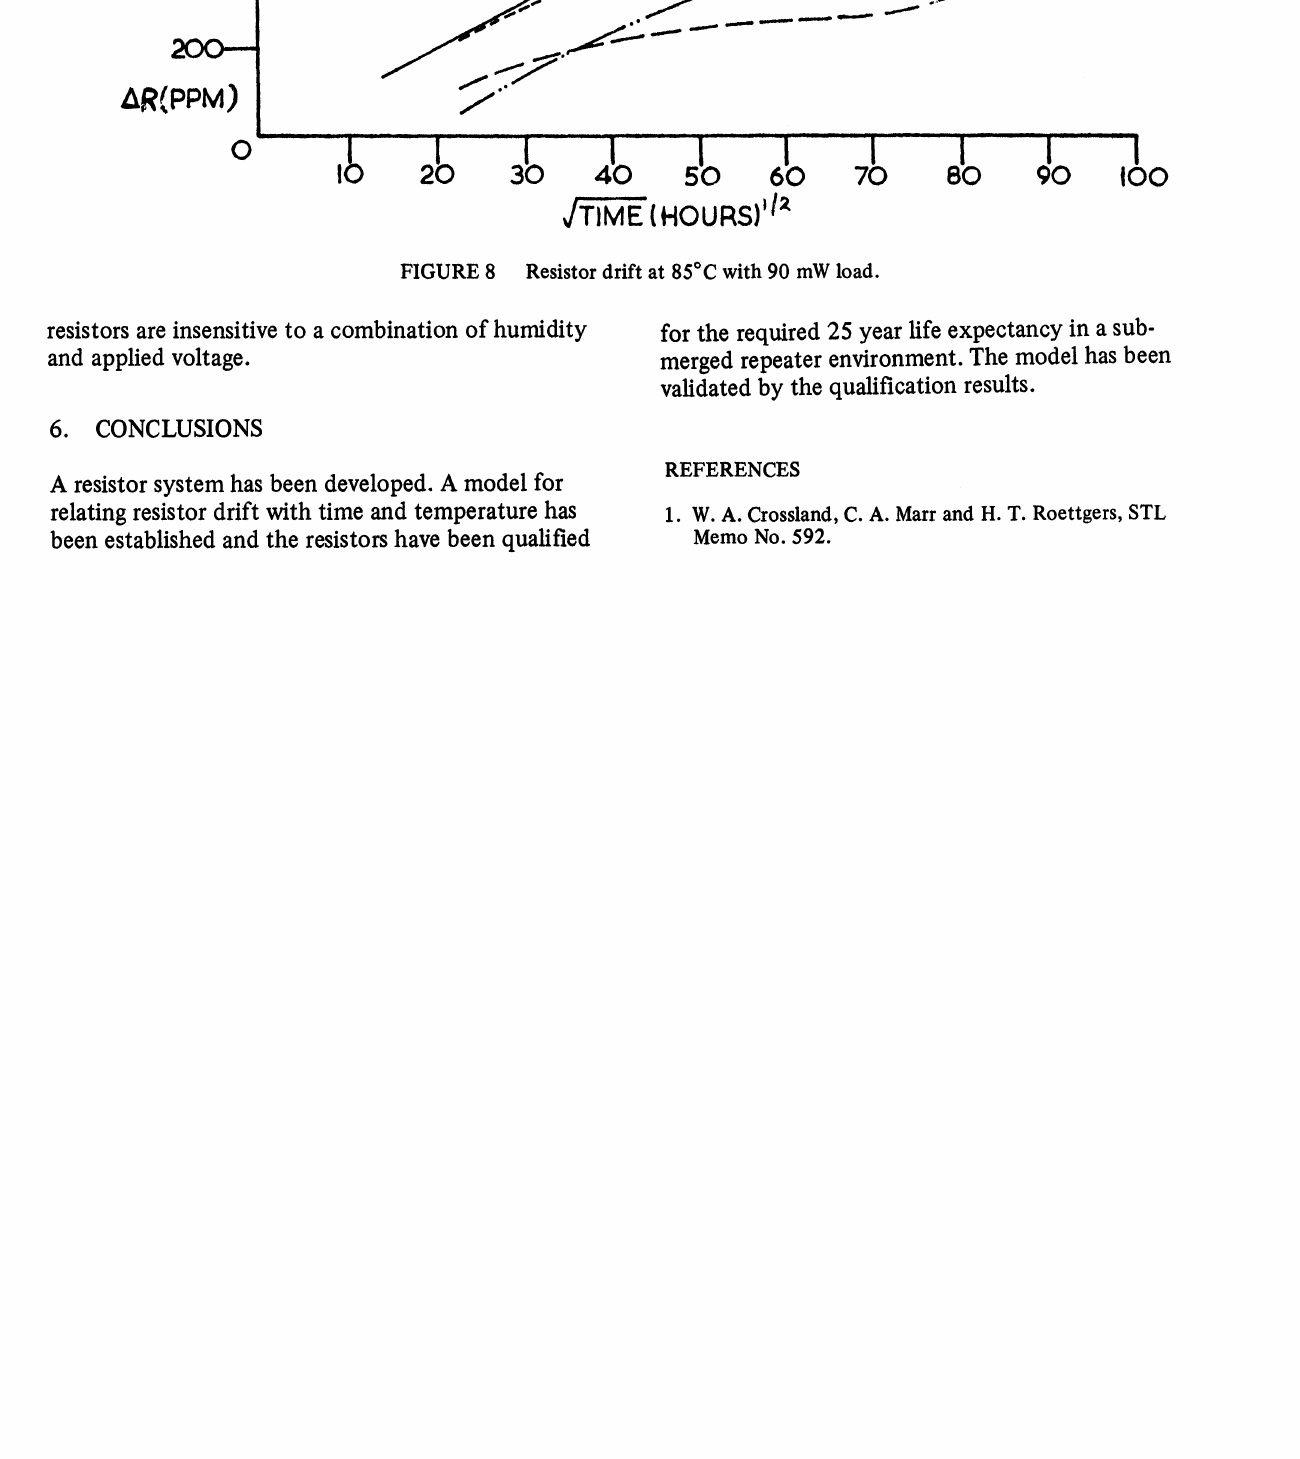
FIGURE 8 Resistor drift at 85C with 90 mW